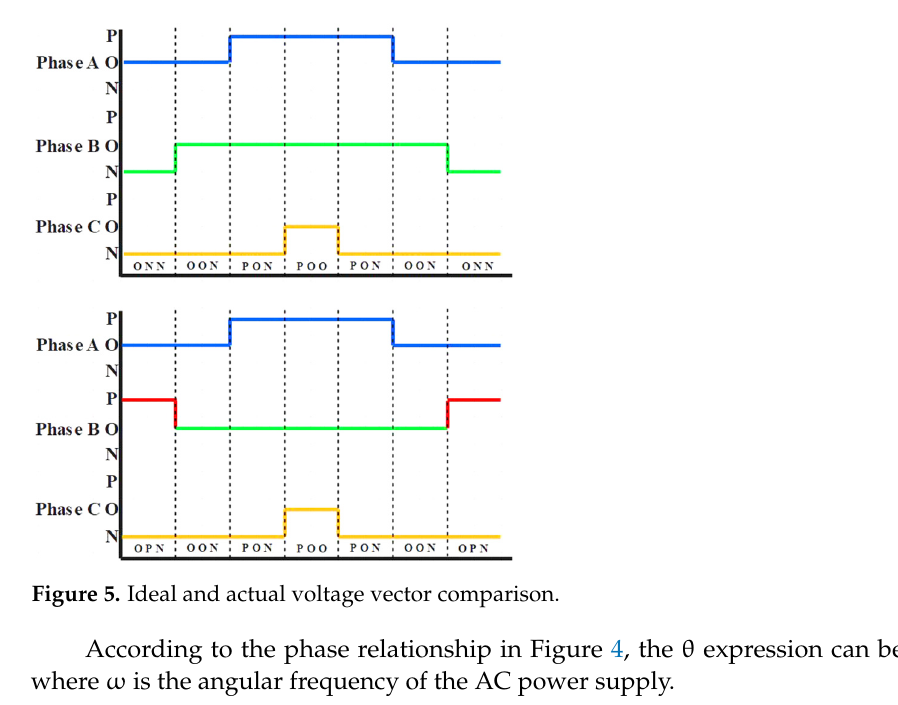
Figure 4. Vector relation of input voltage and current and vector diagram of large sector I space.